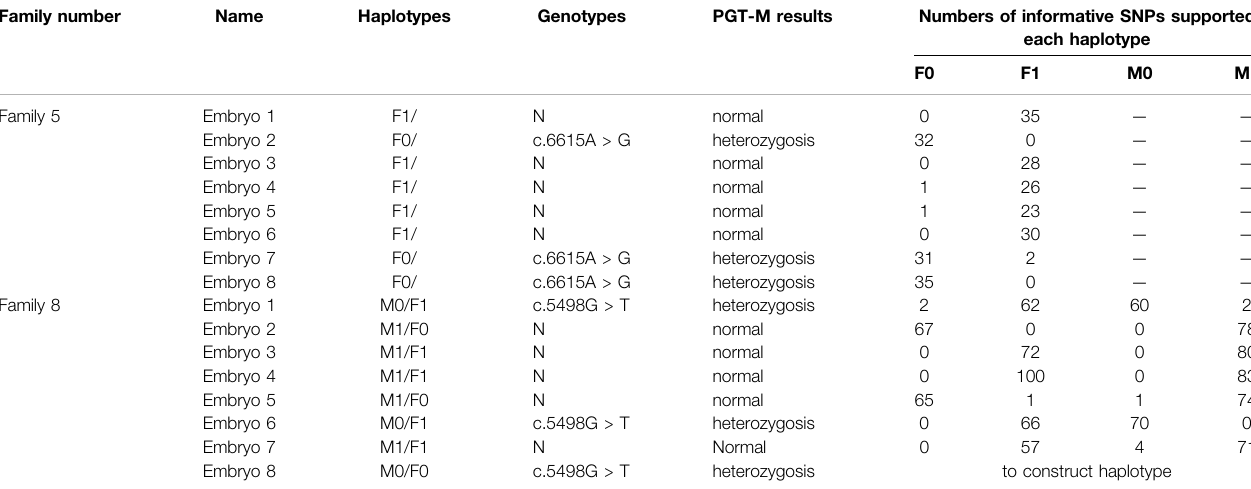
TABLE 4 | Details of haplotype in FBN1 gene in embryos from two Marfan families who chose to do IVF with PGT-M. Family